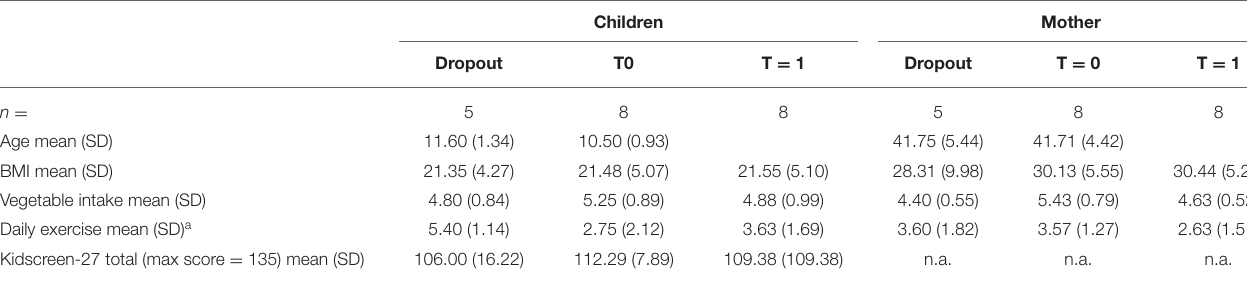
TABLE 1 | Mean score on health behaviors and quality of life at baseline and follow-up.